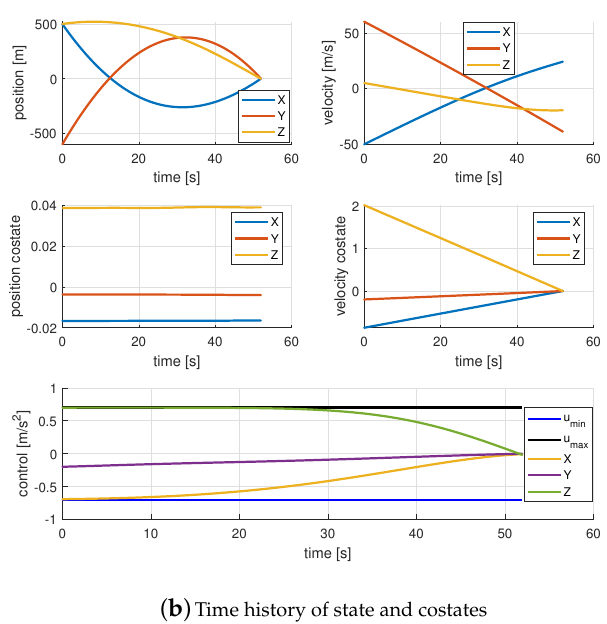
Figure 6. Constrained intercept problem with penalty Γ = 1 ( N = 100 and L =